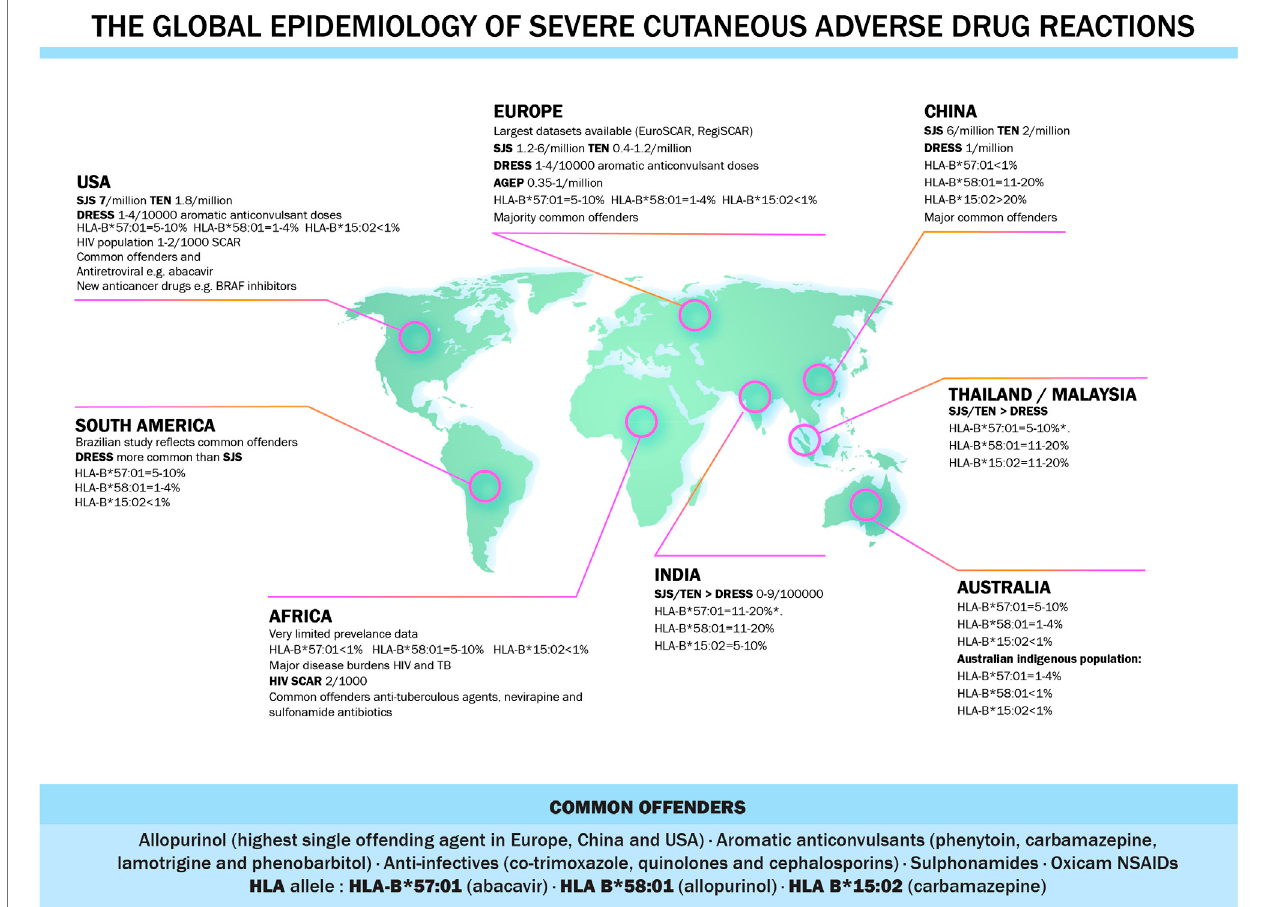
FIGURE 4 | Global epidemiology of severe cutaneous adverse drug